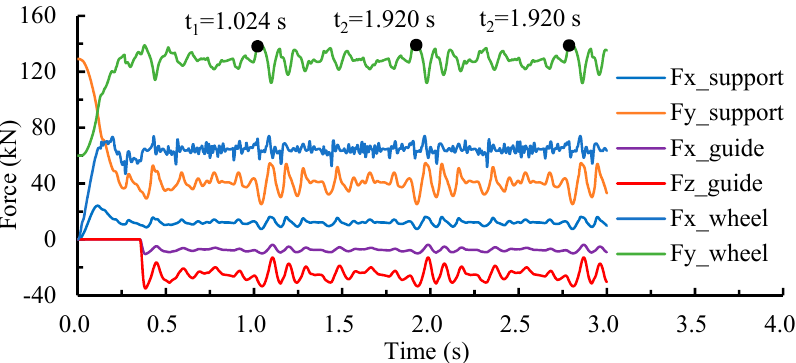
Figure 3. Contact force curve of traction key components.